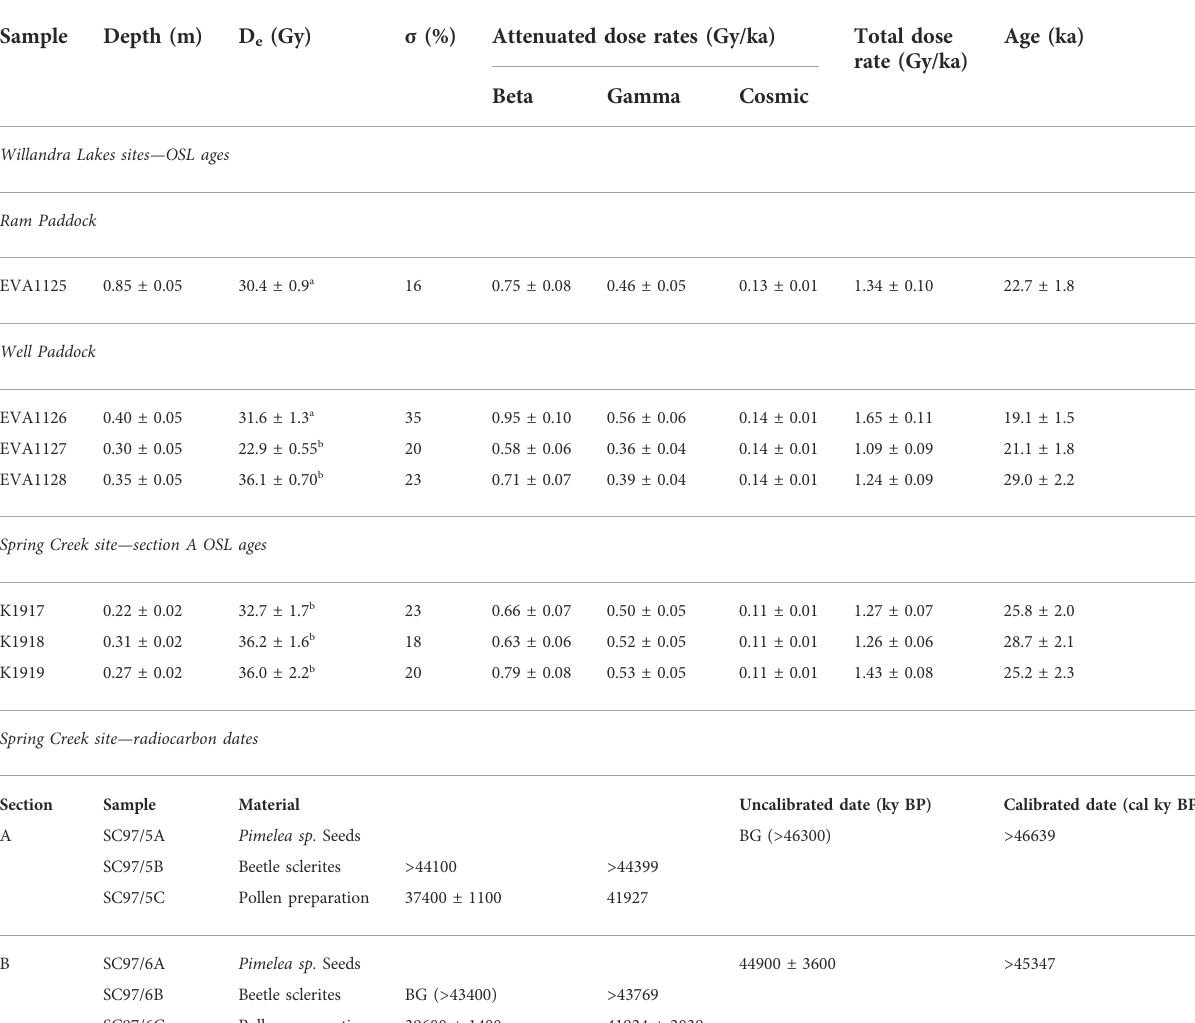
TABLE1Chronologicaldata.SupportingdataandageestimatesbasedonOSLdatingfortheRPLandWPLsitesintheWillandraLakesarea,calculated on single grains of quartz. Supporting data and age estimates based on OSL dating of dark, laminated clayey silts at Spring Creek (Section A), undertaken onsinglealiquotsofquartz.ResultsofAMS 14